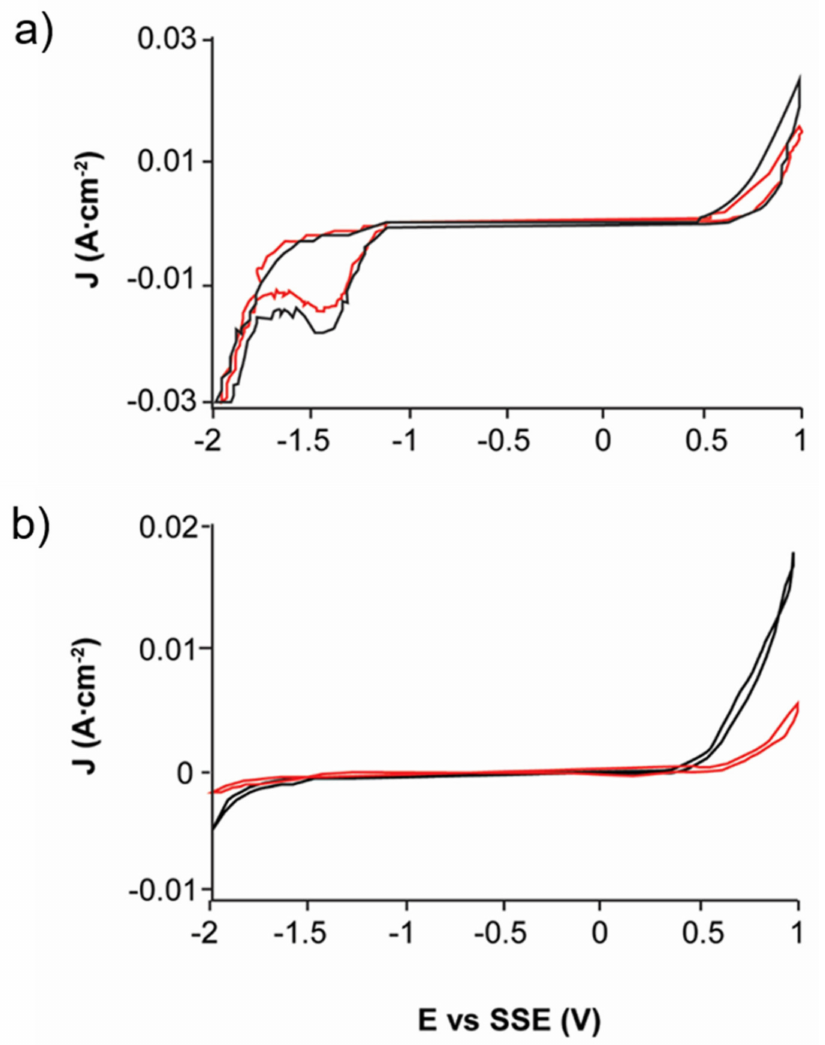
Figure 12. Typical CPE-ZnS voltamperograms (70:30 wt.%) obtained at a scan speed of 100 mVs − 1 , without electrolyte agitation and negative direction. ( a ) 0.1 M H 2 SO 4 , pH = 2; ( b ) 0.1 M Na 2 SO 4 , pH = 7. The black line shows the signal before electrolysis; red line, after